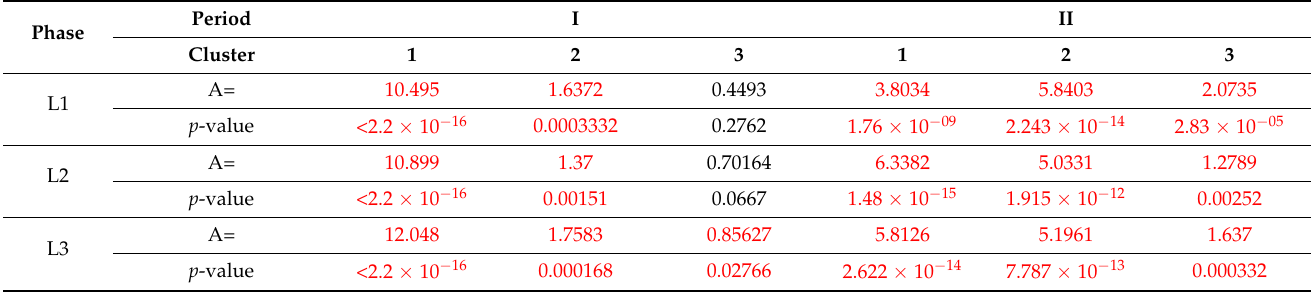
Table 8. Anderson–Darling normality test of the voltage ( α = 0.05) in each phase.